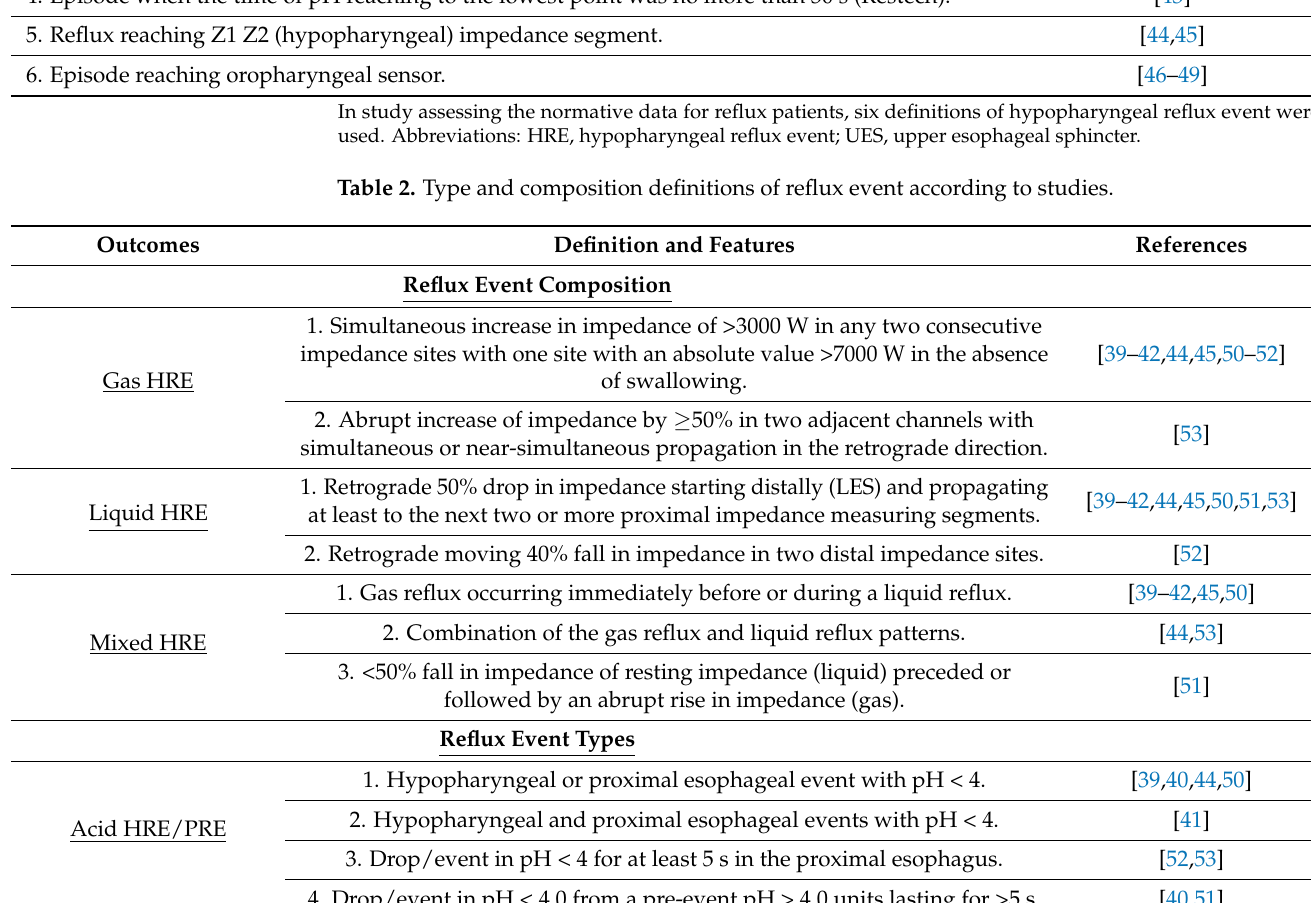
Table 2. Type and composition definitions of reflux event according to